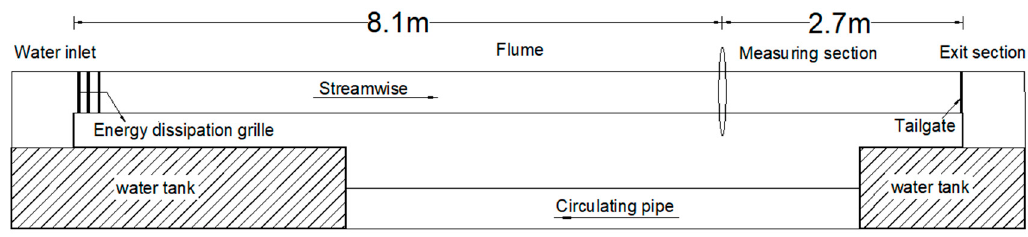
Figure 2. Schematic of the test flume.